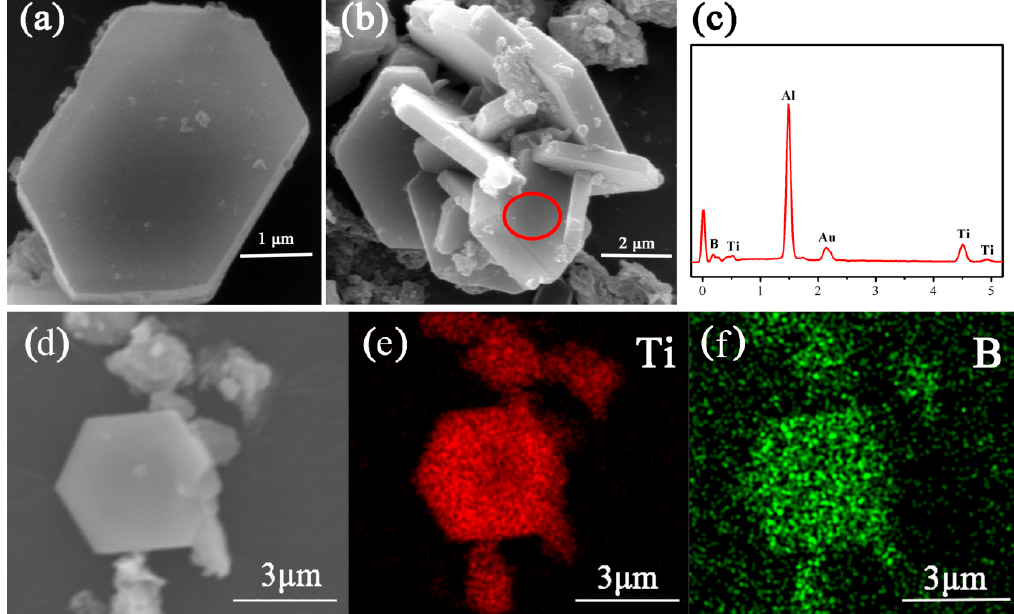
Figure 5. SEM images of (a) monodispersed TiB 2 microplatelet and (b) interlaced TiB 2 microplatelets, (c)corresponding EDS results of TiB 2 microplatelets, (d) a lower magnification SEM image with